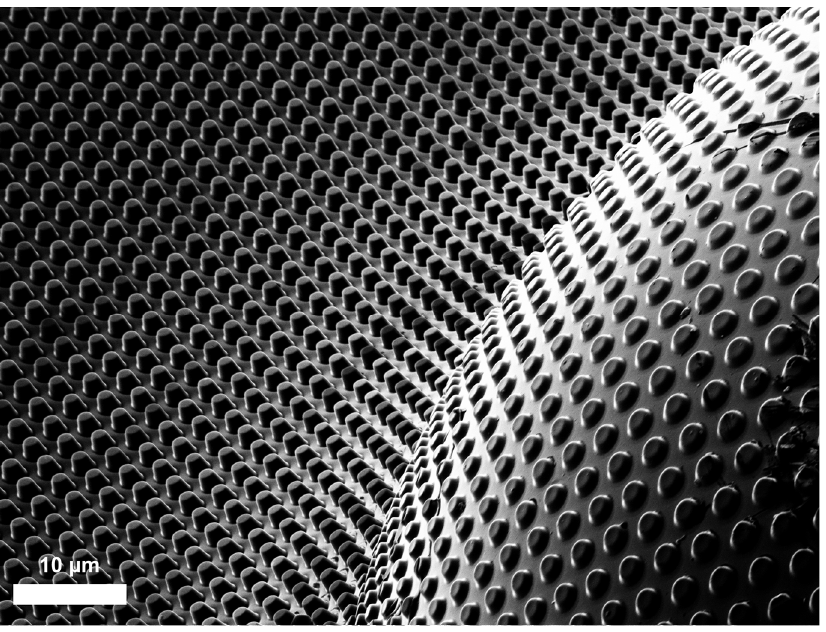
Figure 12. SEM image of microstructures nanoimprinted on top of a microsphere.